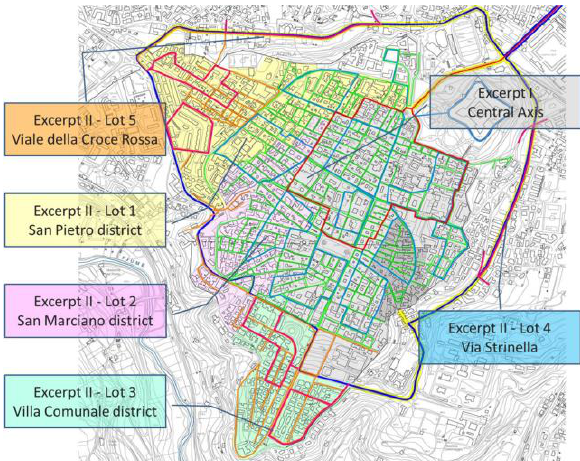
Figure 2. Analysis section of the underground tunnel with the identification of all the housed services